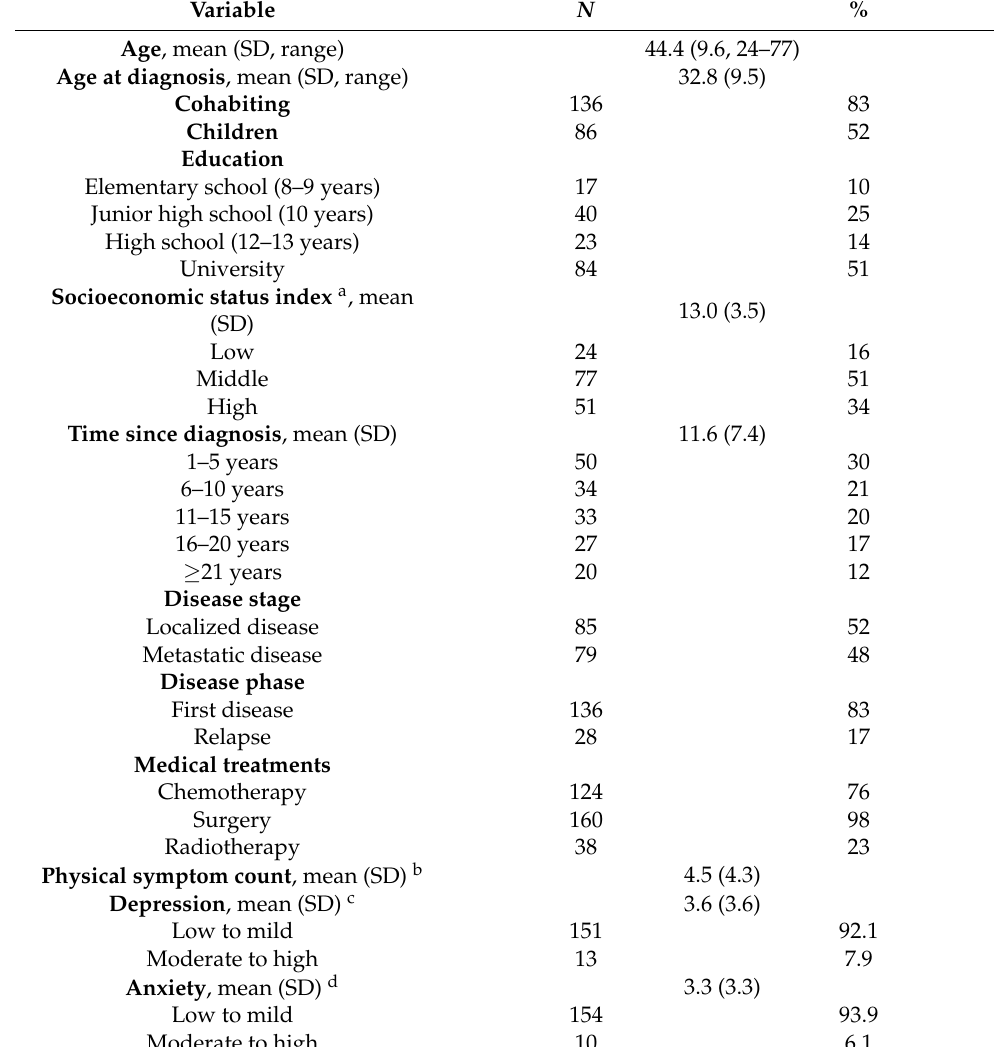
Table 1. Demographic and disease related sample characteristics and descriptive statistics for dependent variables ( N =